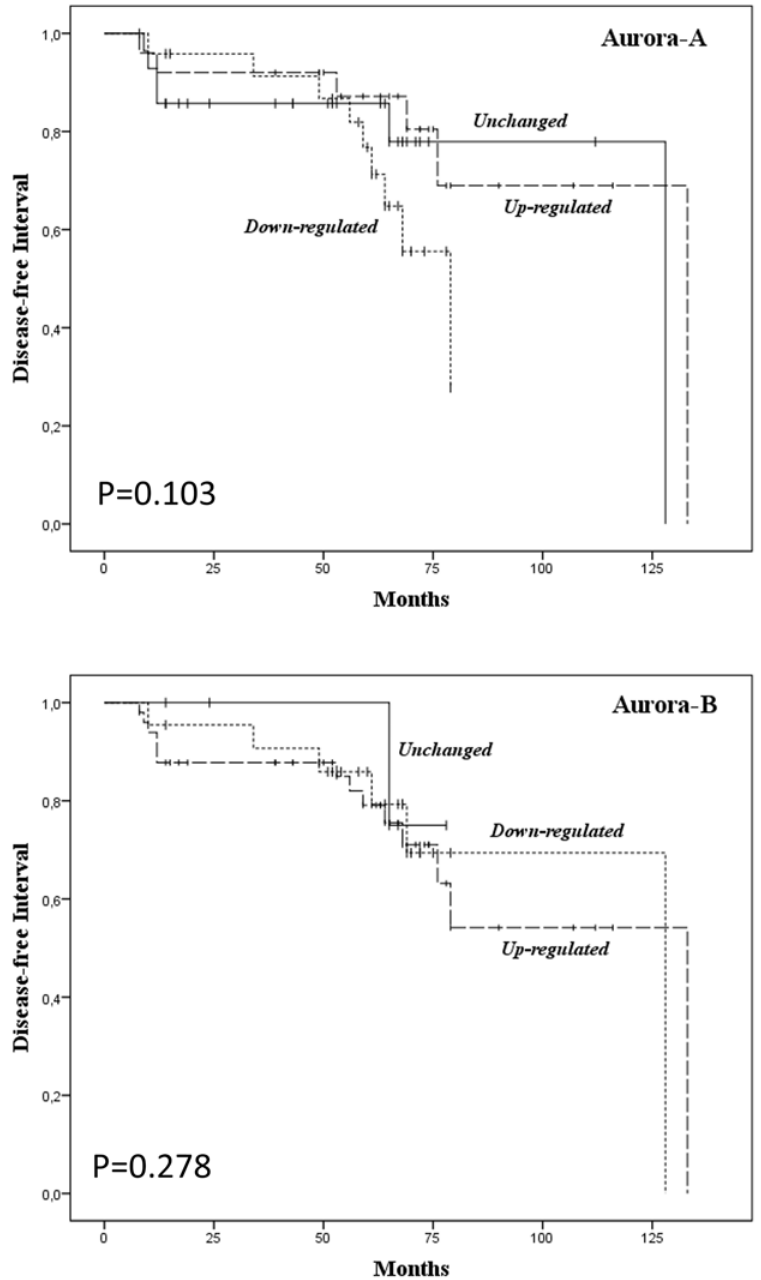
Fig 3. Aurora kinase mRNA levels and disease-free interval (DFI) in papillary thyroid cancer patients. Kaplan-Meier analysis combined with Mantel-Cox log-rank statistical test performed on 75 PTC patients followed-up from 8 to 133